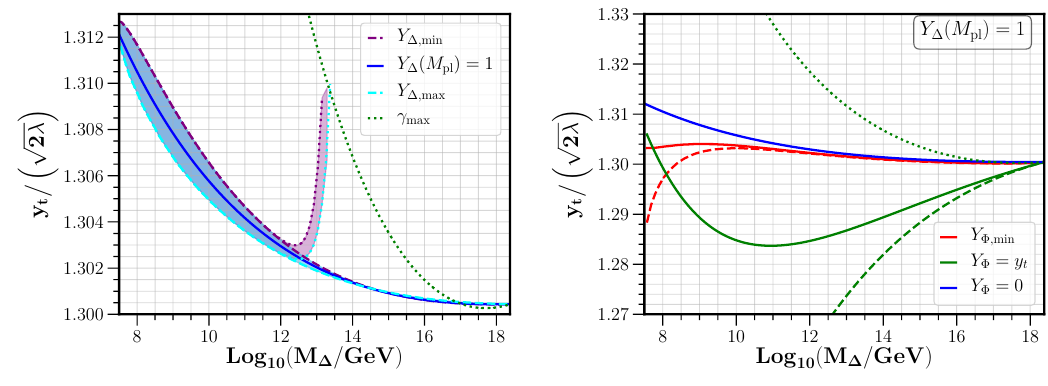
Figure 10 . Predictions on the top Yukawa-Higgs quartic coupling ratio as a function of the intermediate scale M ∆ . The relative change with M ∆ can be directly translated to a prediction for the top-Higgs mass ratio if compared with the ratio for M ∆ = M pl , which is given by y t 1 . 3004 . Left: change in the predictions due to the triplet only. The solid blue line refers to the value Y ∆ ( M pl ) = 1 and the dotted lines are the predictions corresponding to the lower and upper bounds on Y ∆ derived from vacuum stability in section 3.4. The blue shaded region is the range of predictions allowed by vacuum stability with vanishing cubic coupling γ . The purple shadded region shows the prediction when γ is given by eq. (2.19) and the masses of the light neutrinos are due to a seesaw type II. The dotted green line correspond to | γ | = γ max . Right: change in the predictions when right-handed neutrinos are taken into account. We fixed Y ∆ ( M pl ) = 1 . The red lines are the predictions corresponding to the lowest bound on Y Φ , min derived from vacuum stability respectively in section 3.5. For the solid red line we use γ ( M pl ) = 0 and for the dashed red line we set γ ( M ∆ ) = 0 . The green lines are the predictions corresponding to Y Φ ( M ∆ ) = y t ( M ∆ ) . The solid green line obtains for γ ( M pl ) = 0 , the dashed blue line uses γ ( M ∆ ) = 0 and the dotted green line corresponds to the maximum bound γ max in eq. (2.18). The latter would be exactly the same for the lowest bound Y Φ , min since it corresponds to the choice λ ( M ∆ ) = 0 independent of Y Φ . The blue solid line corresponds to the case without right-handed neutrinos, as in the left